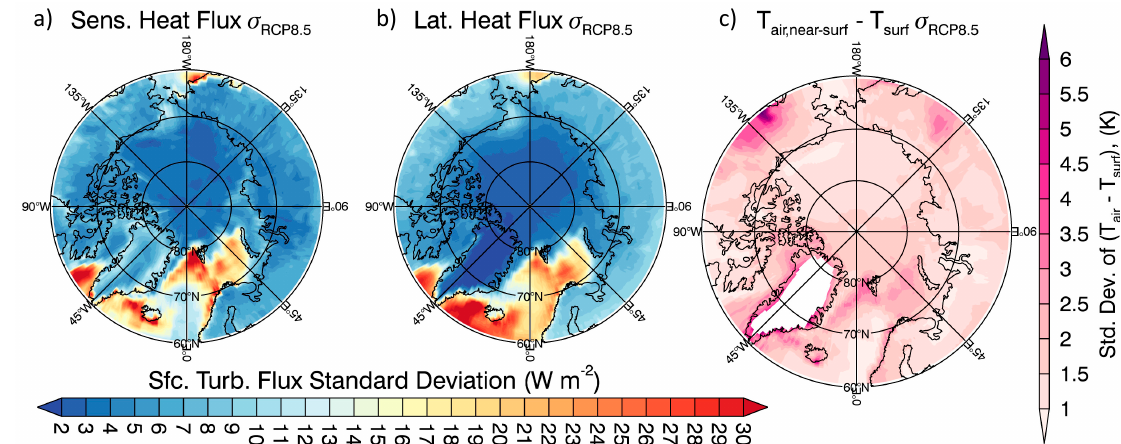
Figure 8. Spatial variations of the inter-model spread represented as the inter-model standard deviation ( σ ) in the present-day annually-averaged ( a ) SH, ( b ) LH, and ( c ) T s –T a poleward of 60° N across a 16-member CMIP5 climate model ensemble using the RCP8.5 forcing. Present-day is defined as the first 20 years of the simulation (2006–2026).